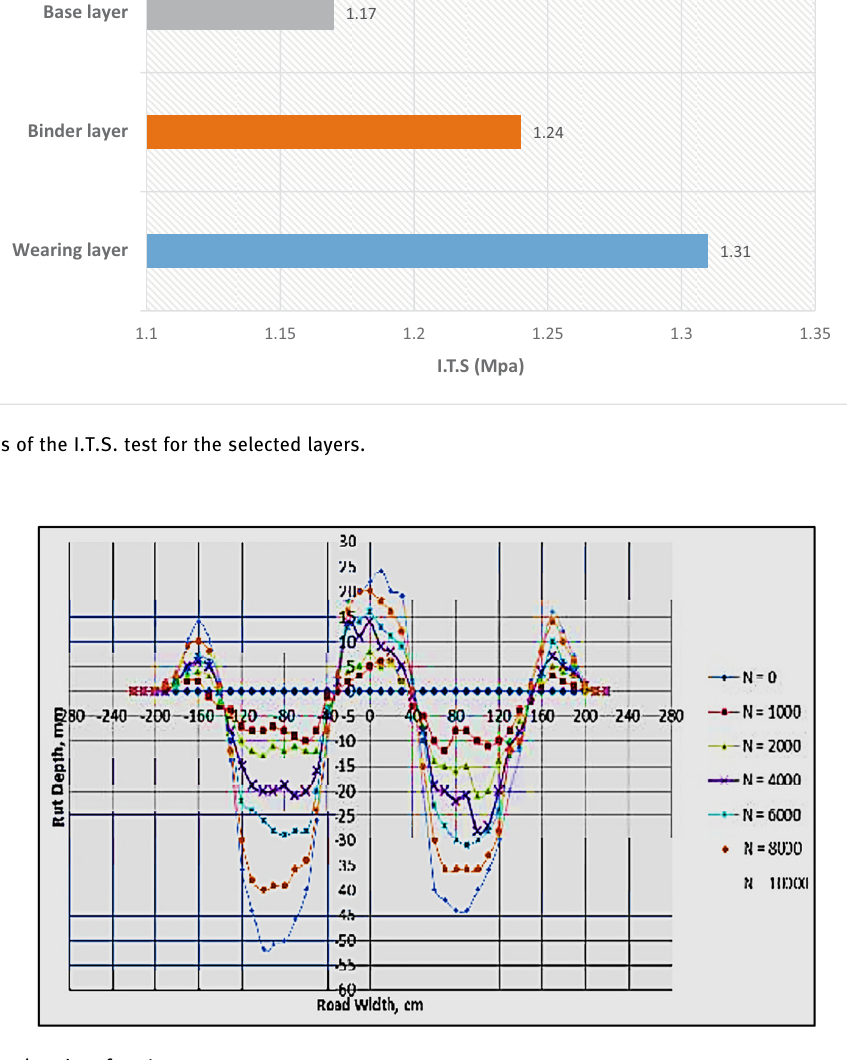
Figure 12: Rutting depth at interface